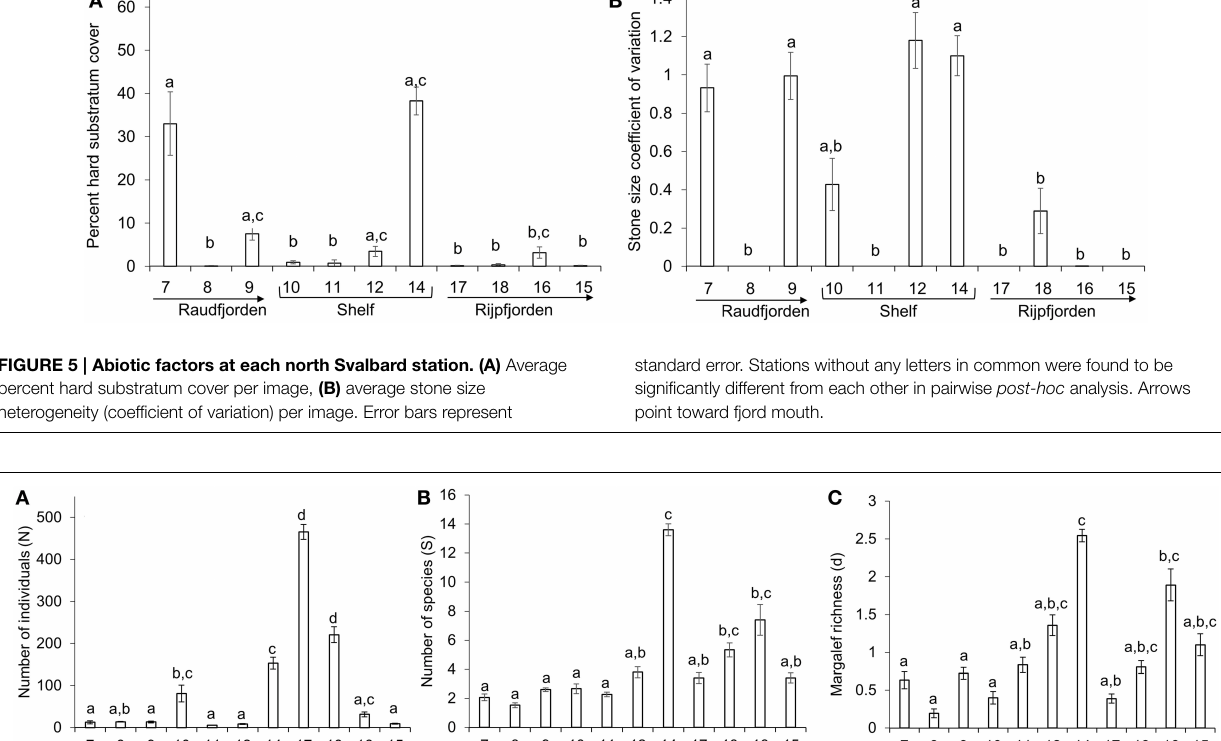
FIGURE 6 | Biotic indices of richness, evenness, and diversity at each station in north Svalbard. (A) Average number of individuals per image, (B) average number of species per image, (C) Margalef richness, (D) Shannon-Wiener diversity index, (E) Pielou